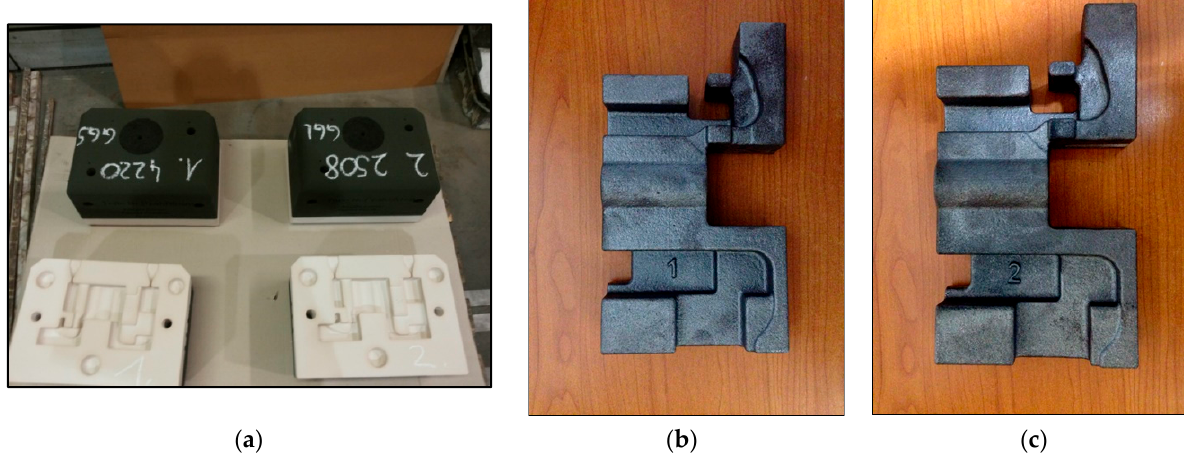
Figure 5. Molding plates and parts ( a ) ceramic molds used for casting the iron parts; ( b ) gray cast iron part with lamellar graphite type EN-GJL-250 resulting from casting and cleaning; ( c ) cast iron part with spheroidal graphite type EN-GJS-400-15 resulting from casting and cleaning.